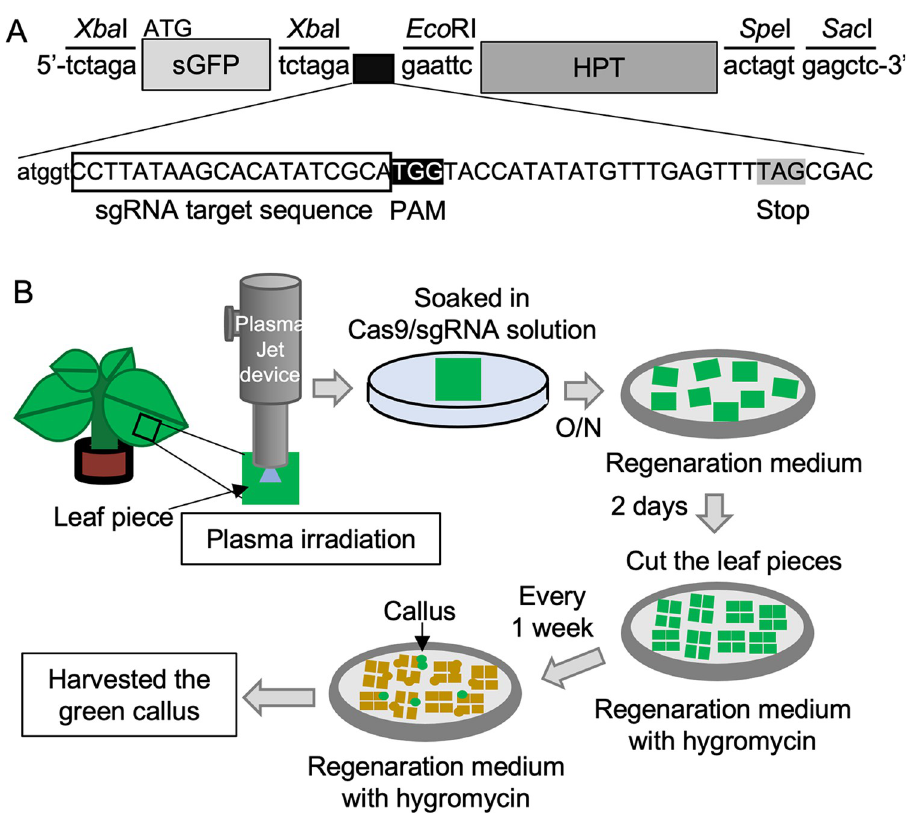
Fig 5. Development of tobacco reporter plant and procedure of plasma treatment. (A) Structure of sGFP-waxy- HPT reporter gene. sGFP , waxy gene (Capital letters), and HPT sequences were connected using restriction enzymes ( Xba I, EcoR I, Spe I, and Sac I) and inserted into the pBI121 vector as described in Materials and Methods. A start codon of sGFP was used for translation. In the original construct, only sGFP-waxy is translated, and the HPT gene is not translated because the translation is stopped at stop codon (TAG) located upstream of the HPT gene in waxy gene sequence, producing no hygromycin resistance. sgRNA target sequence was designated as that comprising 20 nucleotides located immediately upstream of PAM sequence (TGG). Cas9/sgRNA digests at a site located approximately 3 to 4 base pairs upstream of the PAM sequence. HPT sequence can be changed in-frame when a frameshift occurs upon misrepair after digestion by Cas9/sgRNA, leading to the translational fusion of sGFP-waxy- HPT, which can exhibit hygromycin resistance. (B) Scheme of generating genome-edited tobacco plants by introducing Cas9/sgRNA into the cells using plasma. A leaf piece of sGFP-waxy-HPT reporter tobacco was irradiated by N 2 plasma. The treated leaf piece was soaked in Cas9/sgRNA or BSA solution and kept overnight (O/N). The leaf pieces were transferred to regeneration medium plate and maintained for 2 days. The leaf piece was cut into 4 pieces and transferred on the regeneration medium plate containing hygromycin. The leaf pieces were transferred to new regeneration medium plate containing hygromycin every week. Calli appeared on regeneration medium plate upon cultivation of tobacco leaf pieces. Since green calli should be hygromycin resistant, a green callus was harvested for further analysis.